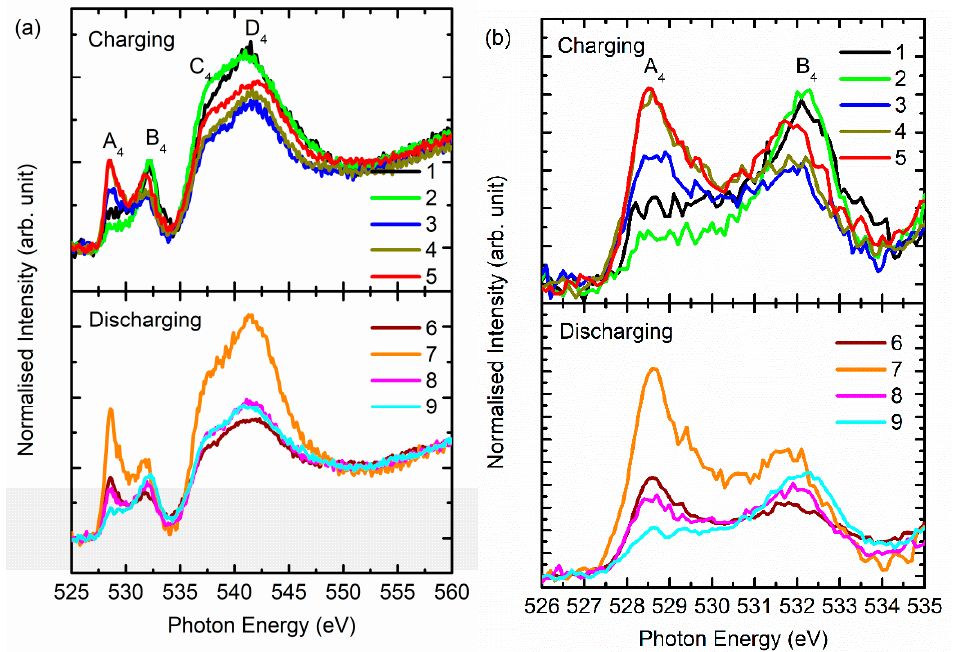
Figure 8. ( a ) O K -edge spectra and its ( b ) pre-edge region for the NCM811 cathode material during charging and discharging.